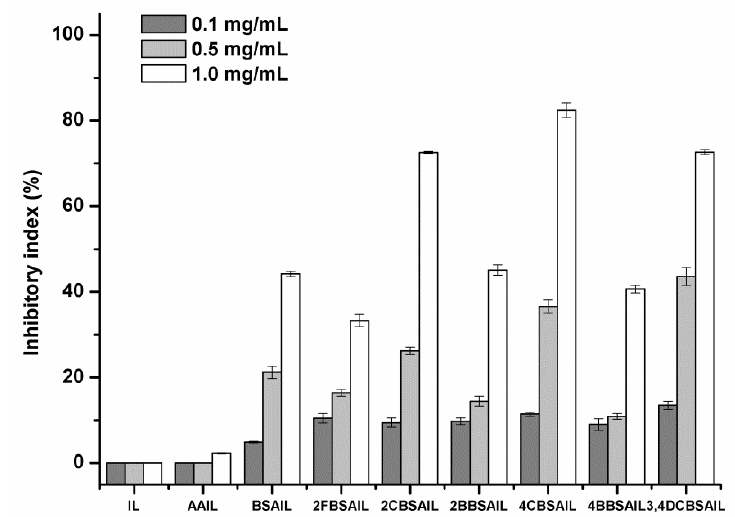
Figure 8. The antifungal activity of inulin, AAIL, and inulin derivatives against Phomopsis asparagi.